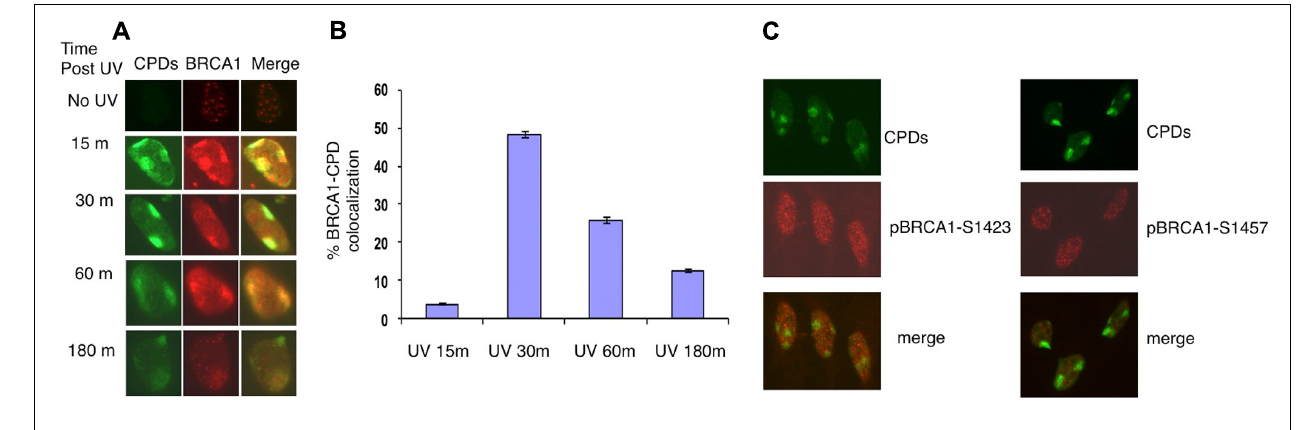
bars represent the SD in three separate experiments. (C) No accumulation of phosphorylated BRCA1 at Ser1423 and Ser1457 at sites of CPDs. HeLa cells were UV irradiated (100 J/m 2 ) through micropore filters and co-stained 30 min later with CPD antibodies and antibodies specific for BRCA1 phosphorylated at Ser1423 and Ser1457 sites,